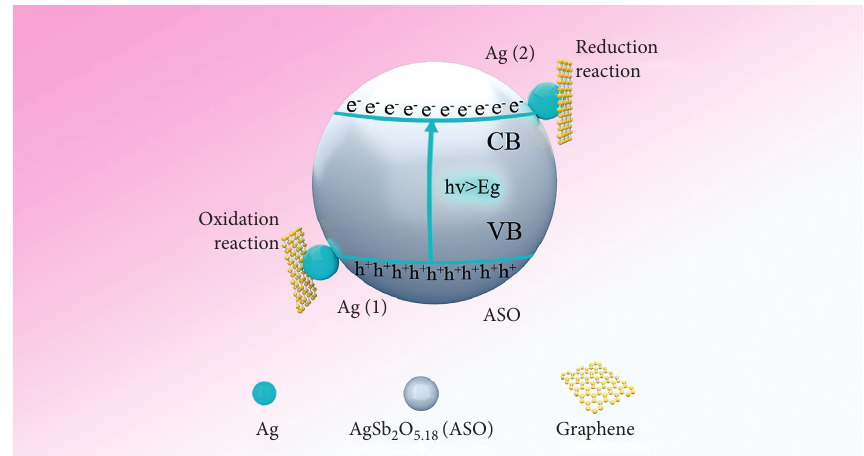
Figure 10: Model of charge separation proposed for G@Ag/ASO.